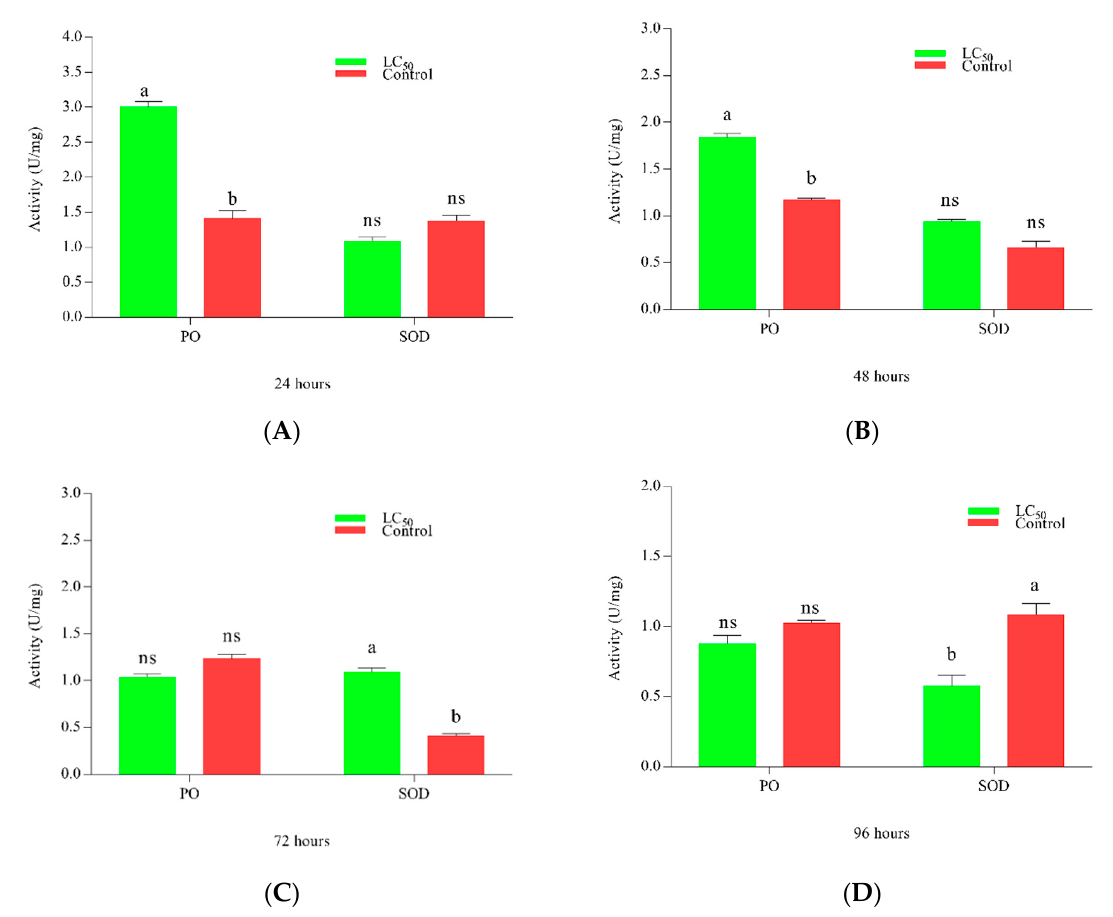
Figure 4. Activity of phenoloxidase (PO) and superoxide dismutase (SOD) activity in Plutella xylostella against LC 50 of Metarhizium anisopliae . Time-dependent activity is shown in the figure, the green color bar shows the activity of enzymes whereas the red bar represents the control. ( A – D) shows the activities of enzymes after 24, 48, 72, and 96 h respectively. Error bars show 95% confidence intervals (CI). Letters indicate significant differences at p < 0.005. (ns = non-significant).